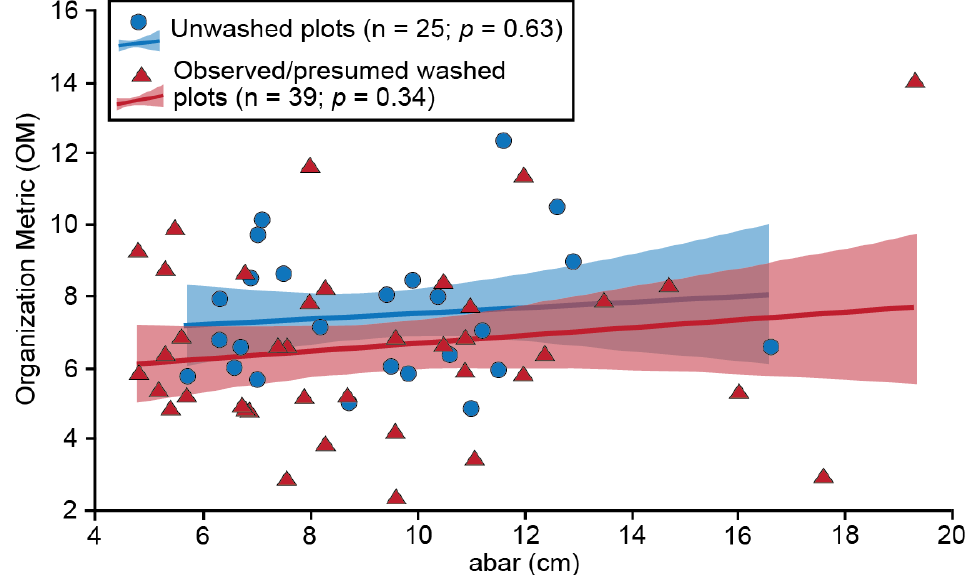
Figure 11. Comparison of OM for unwashed (blue circles) and O/P washed (red triangles) beach plots in Prince William Sound, sampled in June 2010. Solid lines are linear regression fits; translucent windows are 90% confidence intervals.